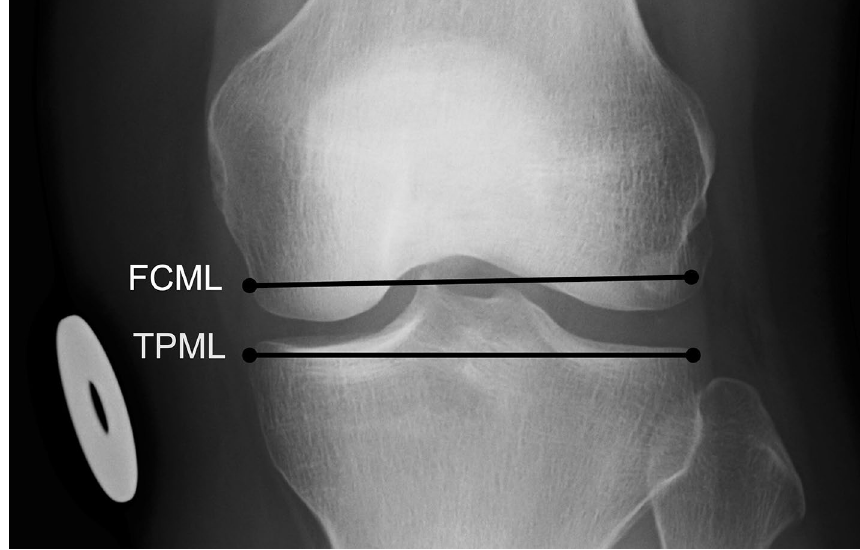
Figure 1. Knee measurements. FCML mediolateral breadth of femoral condyles, TPML mediolateral breadth of tibial plateau. Diameter of the calibration disc: 30